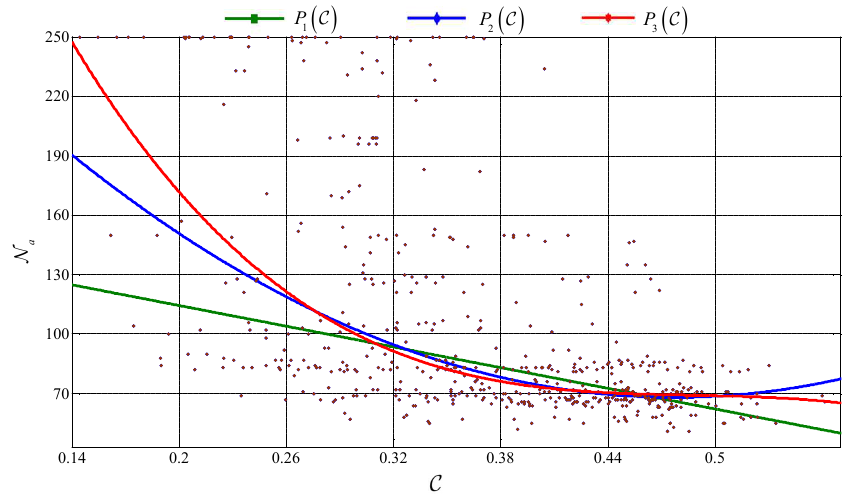
Figure 10. Polynomial curve N a = P n ( C ) between the complexity C and the estimated N a